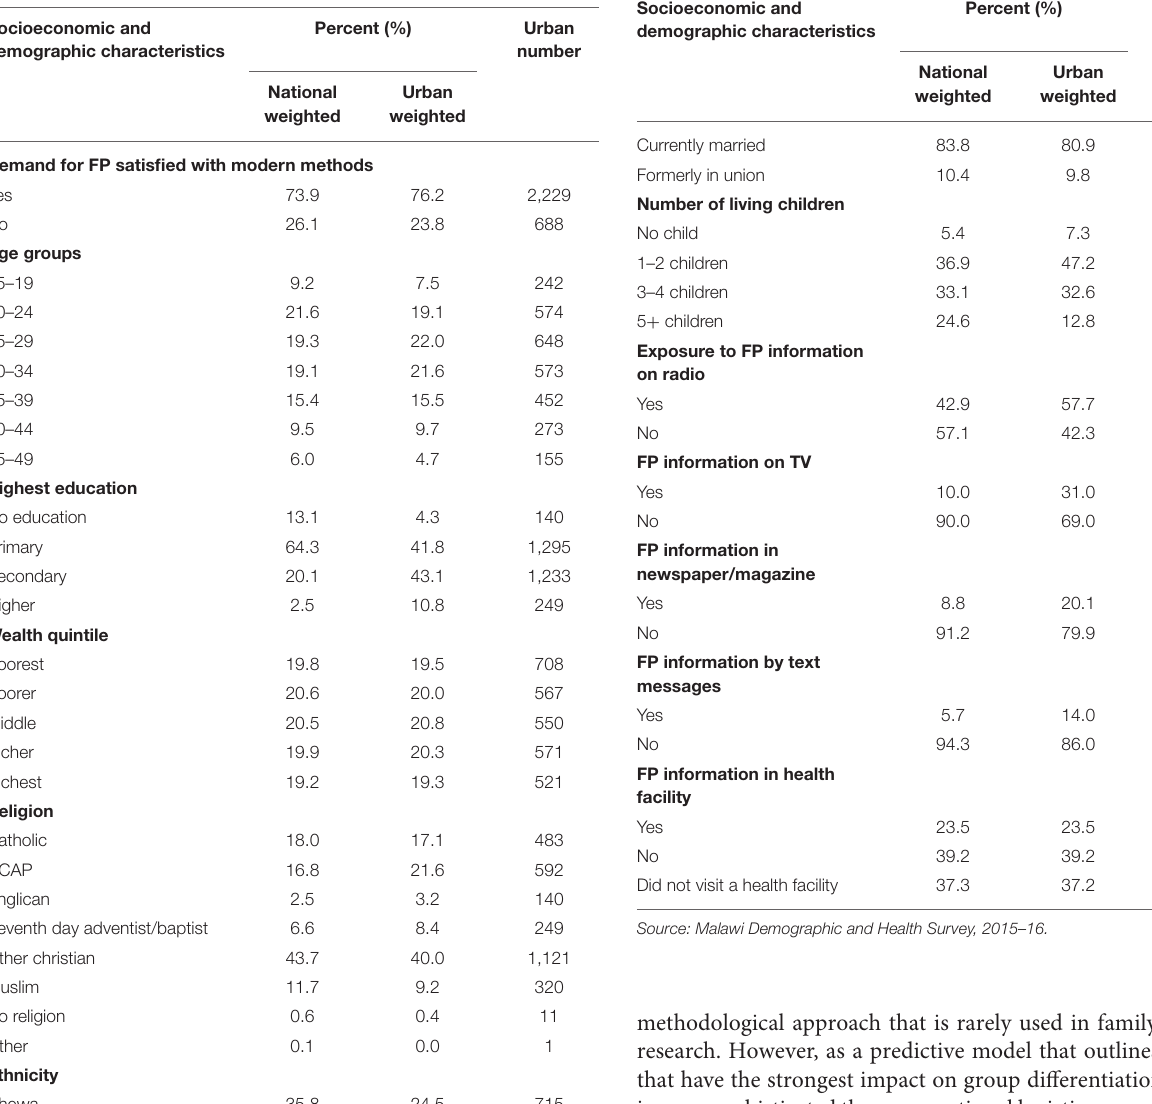
Socioeconomic and Percent (%) Urban demographic characteristics number National Urban weighted weighted